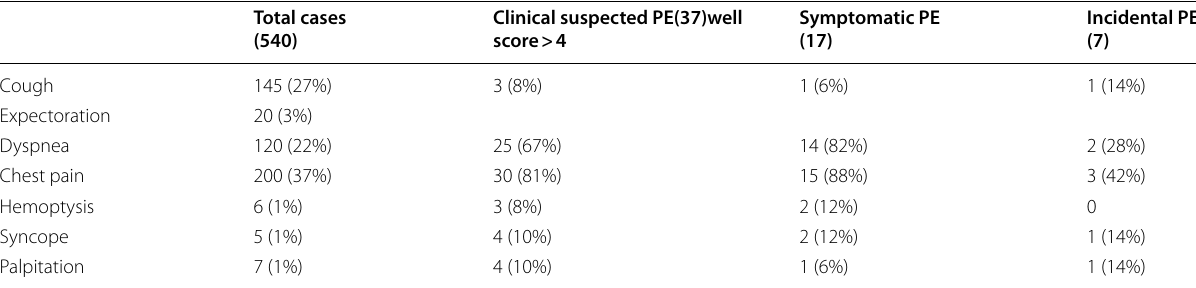
Table 4 Presentation of symptoms among studied groups